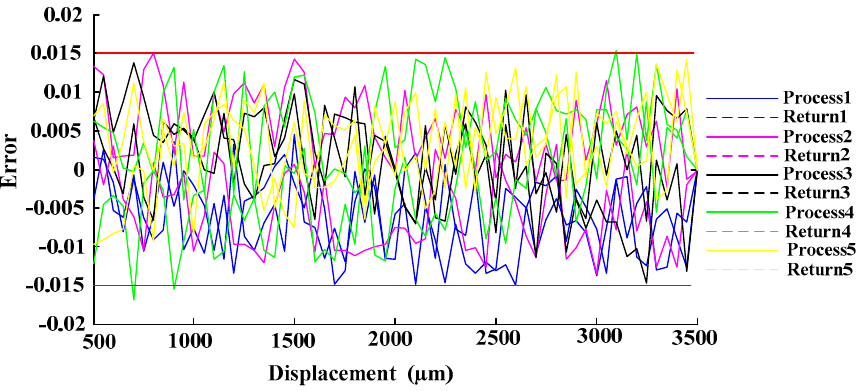
Figure 15. Ratio-displacement curves of the two receiving fibers. Sensors 2016 , 16 , 1508